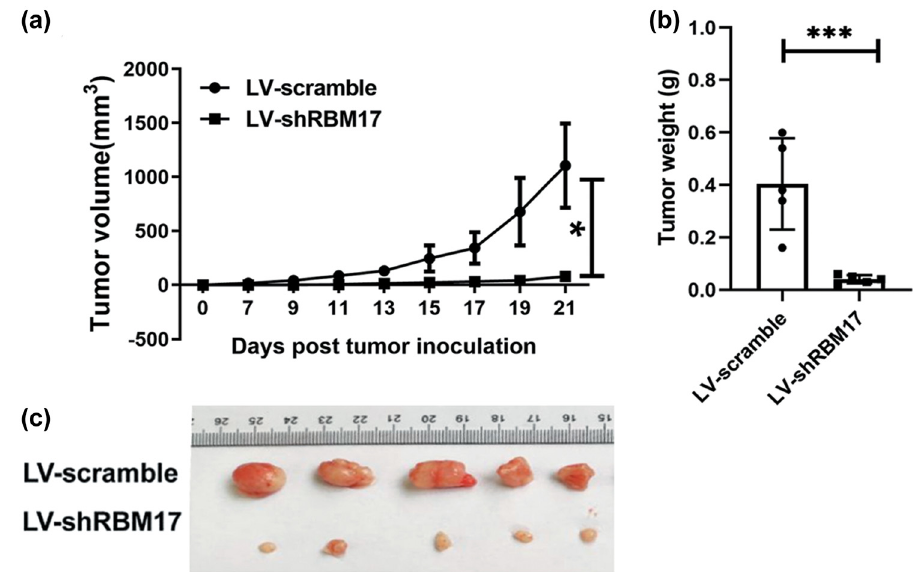
Figure 4: Knockdown RBM17 inhibits FaDu HSCC tumor growth in vivo . ( a ) Tumor volume was measured every 2 days from day 7 to day 21. ( b ) Tumor weight was calculated at day 21. ( c ) Representative images of FaDu HSCC xenograft tissues in di ff erent groups. * P < 0.05, *** P <